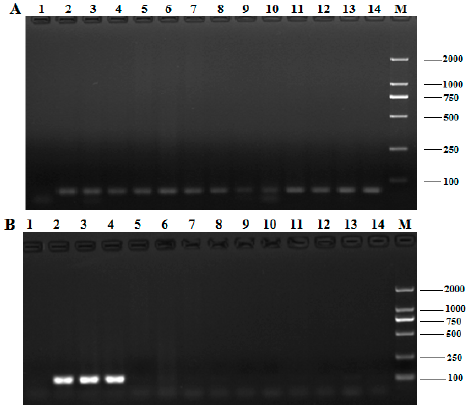
Figure 2. Specificity of the Pol gene detection in qualitative PCR. ( A ) The electrophoresis profiles of the DNA products amplified by the 18S rDNA; ( B ) the species specific identification of the Pol gene